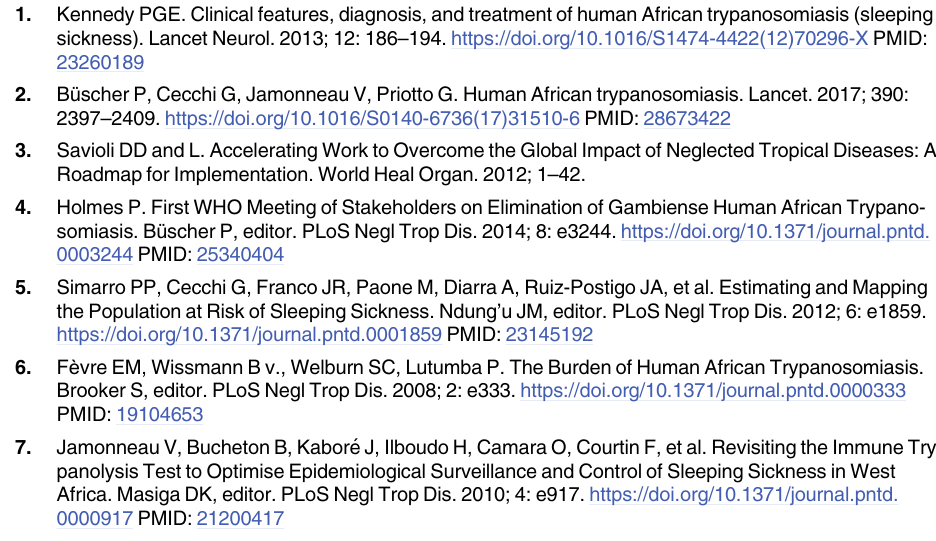
S13 Fig. Raman peak intensity ratio graphs for the remaining Raman peaks that varied during the murine infection compared to uninfected control